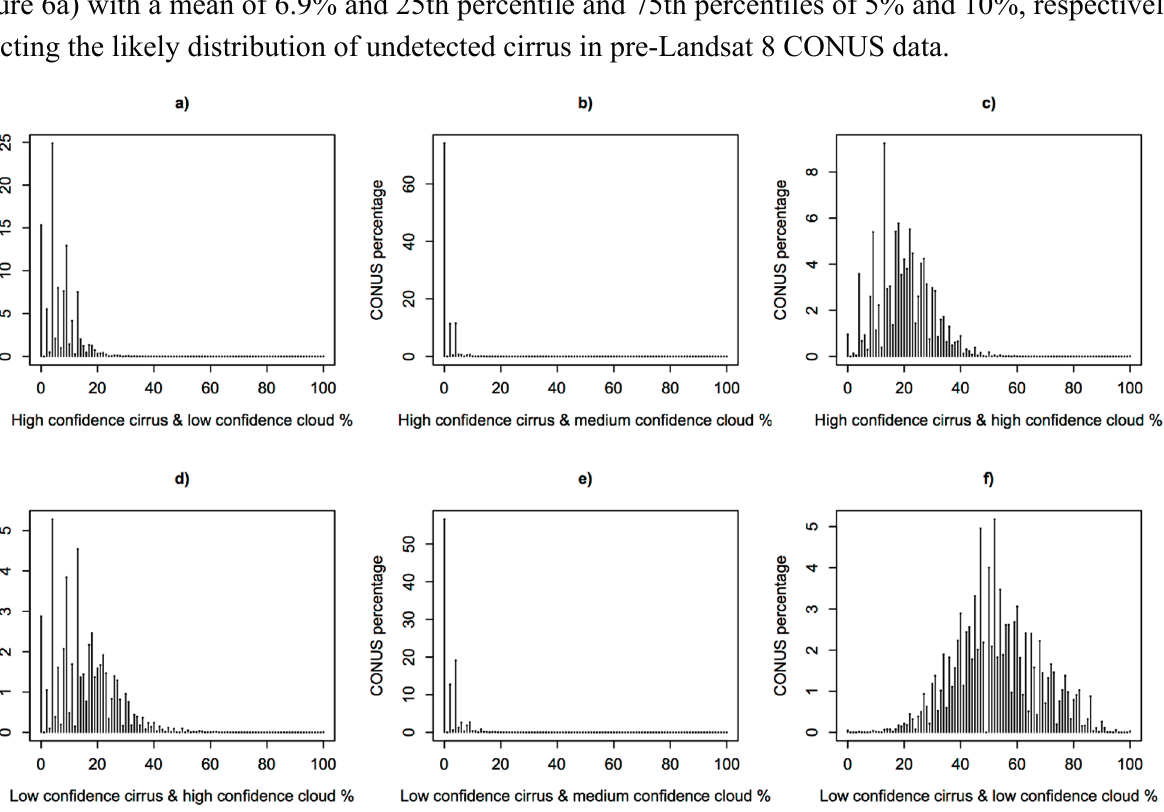
Figure 6. Histograms of the conterminous US (CONUS) percentage values of the ( a – f ) six different possible combinations of coincident cloud and cirrus states for the annual percentages derived over 53 weeks of Landsat 8 observations at each 30 m conterminous US Albers projection pixel location. Percentages were derived considering 11,088,916,742, 30 m CONUS pixel